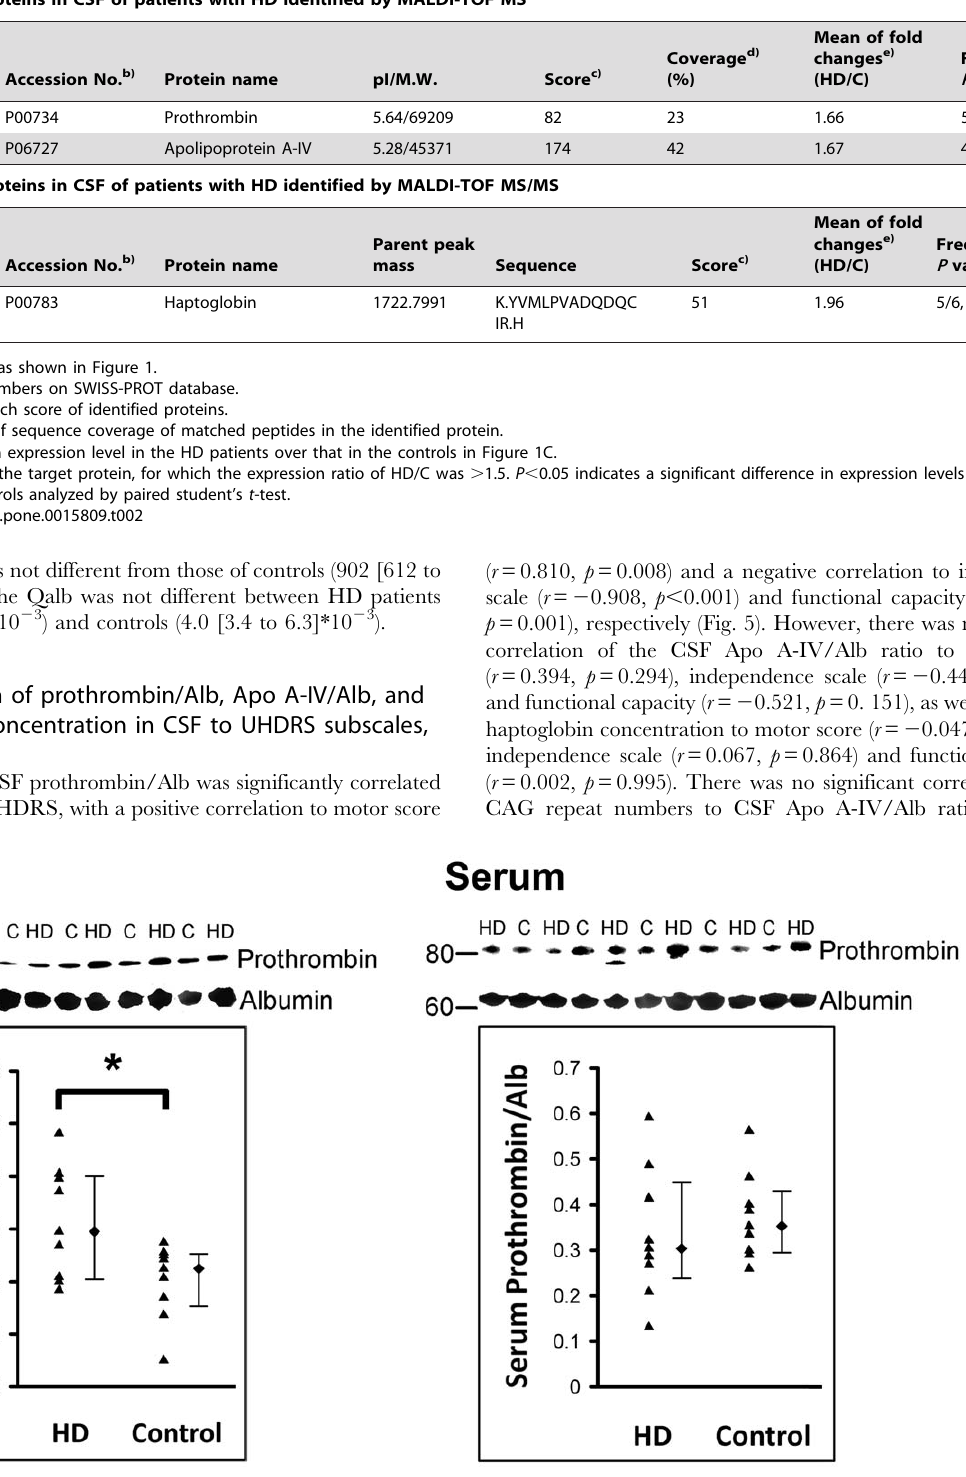
Up-regulated proteins in CSF of patients with HD identified by MALDI-TOF MS